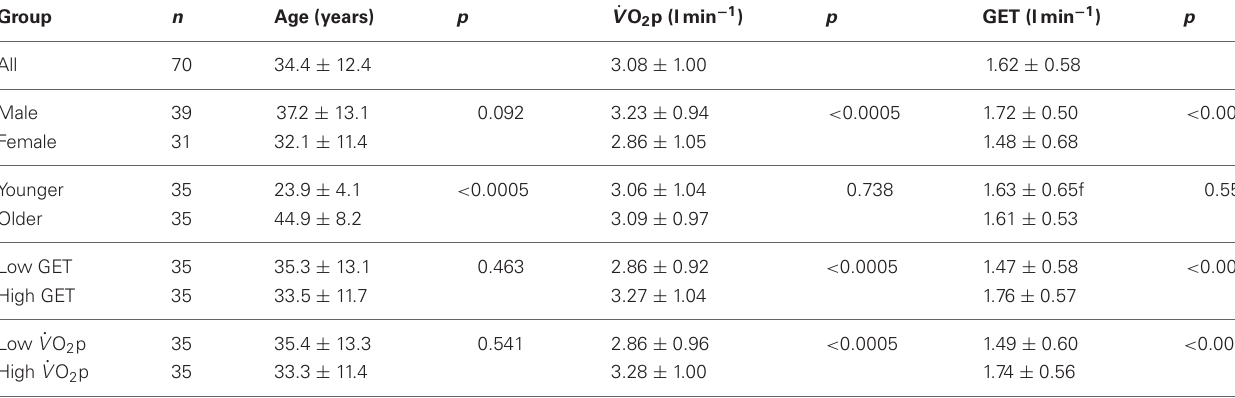
Table 1 | Age and “fitness” distributions for the dichotomised groups (gender, age, ˙ V O 2 p, GET). Group